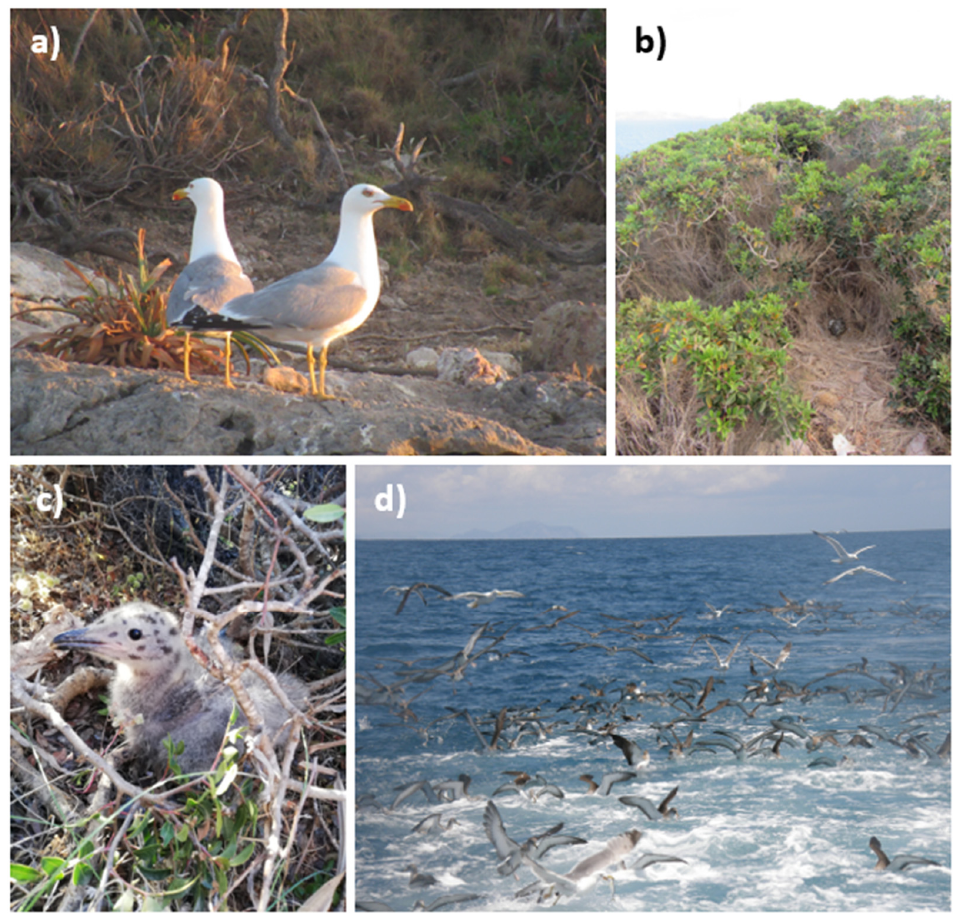
Figure 1. Photos of typical L. michahellis activity: ( a ) adult breeding pair, ( b ) ground nest with egg, ( c ) L. michahellis chick, ( d ) mixed flock foraging in the wake of a fishing vessel. Photos: Georgios Karris.